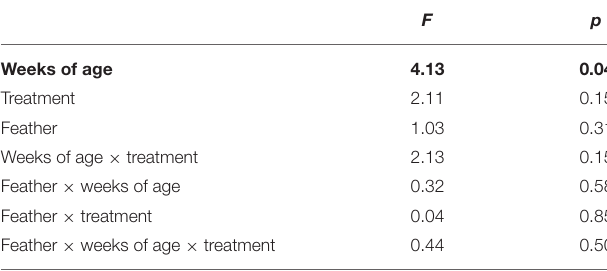
TABLE 3 | Statistical results of CORT in primary wing feathers (pg CORT/mg feather, repeated measures